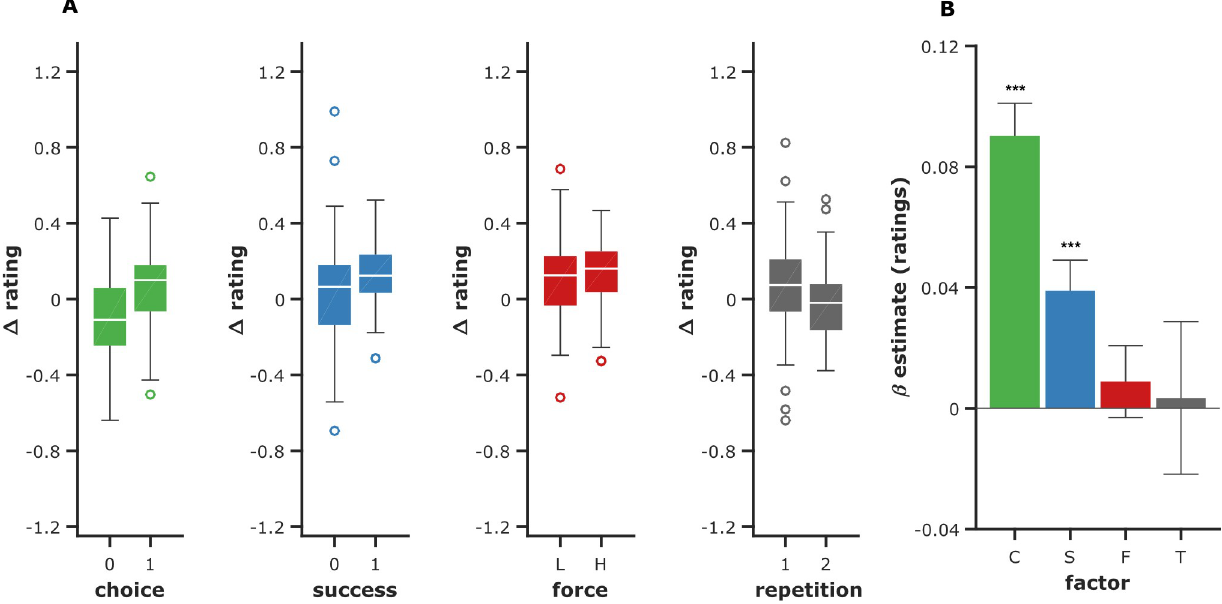
Fig 3. Influence of past actions on desirability ratings. (A) Left panels show the change in rating (R2-R1 and R3-R2 taken together) as a function of choice (0: unchosen, 1: chosen), success (0: unsuccessful, 1: successful), and exerted force (L: low, H: high, according to a median split). All trials were included to test the effect of choice, only accepted trials for the effect of success, and only successful trials for the effect of exerted force. The right most panel show the effect of task repetition (1 is R2-R1, 2 is R3-R2). White line: median, points are drawn as outliers if they are larger than Q3+1.5 � (Q3-Q1) or smaller than Q1-1.5 � (Q3-Q1), where Q1 and Q3 are the 25th and 75th percentiles, respectively. (B) Regression estimates corresponding to the choice (C), success (S), and force (F) factors, and to the intercept (T for time). Error bars represent inter-subject SEM. Stars and dots: � p < 0.05; �� p < 0.01; ��� p <